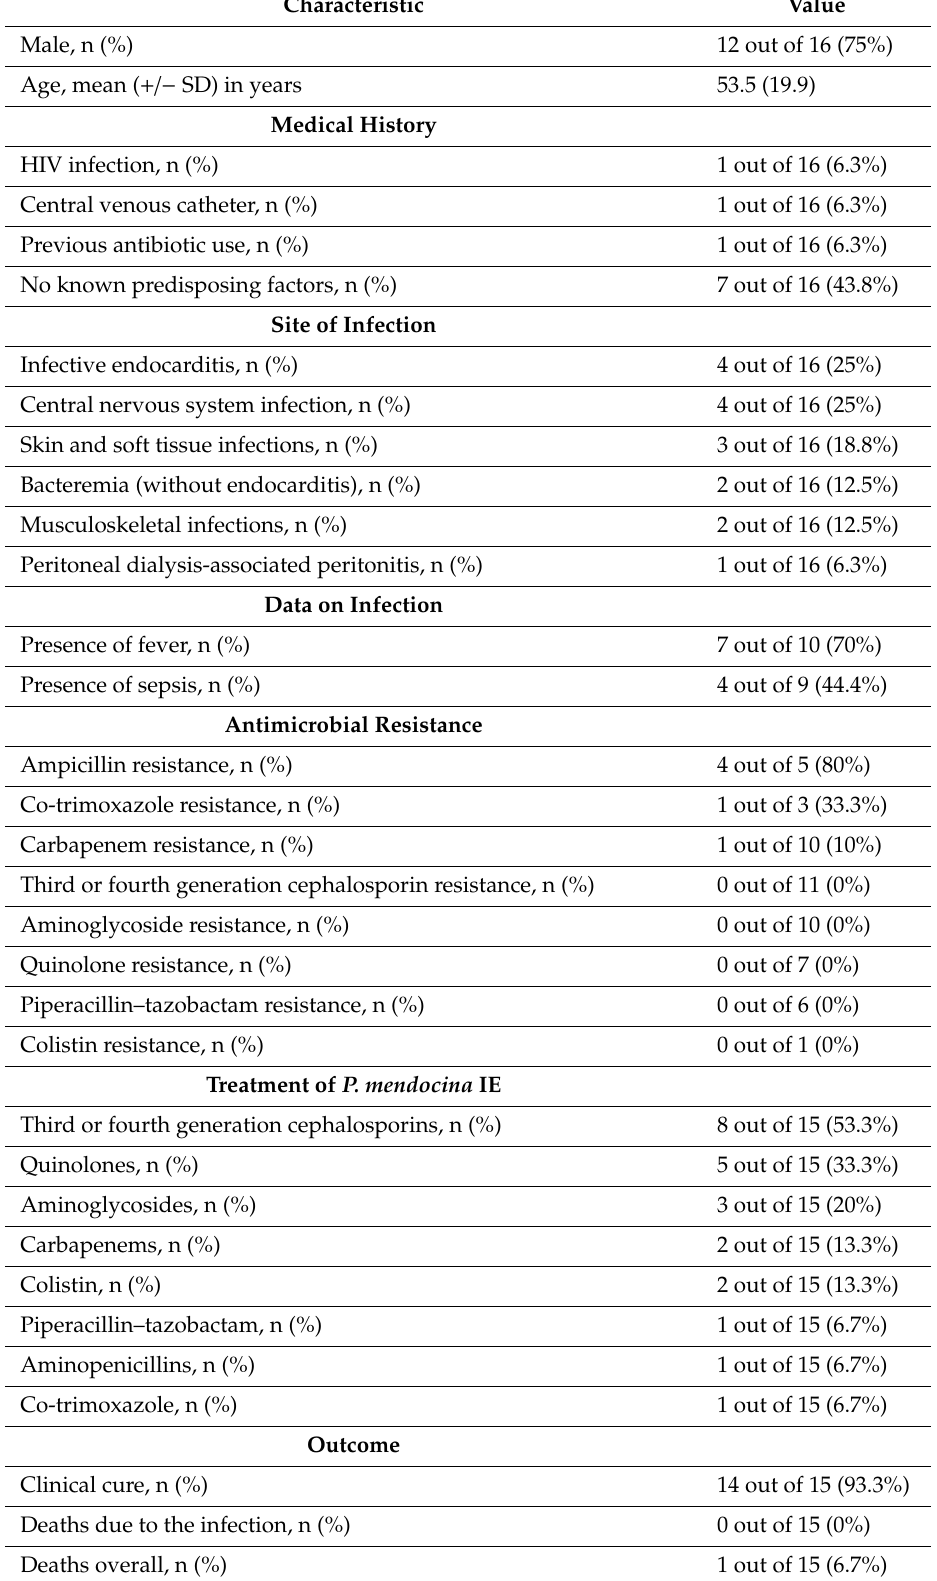
Table 1. Characteristics of 16 patients with infections by Pseudomonas mendocina : site of infection, antimicrobialresistance, treatmentandoutcomes. Valuesshowcasesamongpatientswithavailabledata.